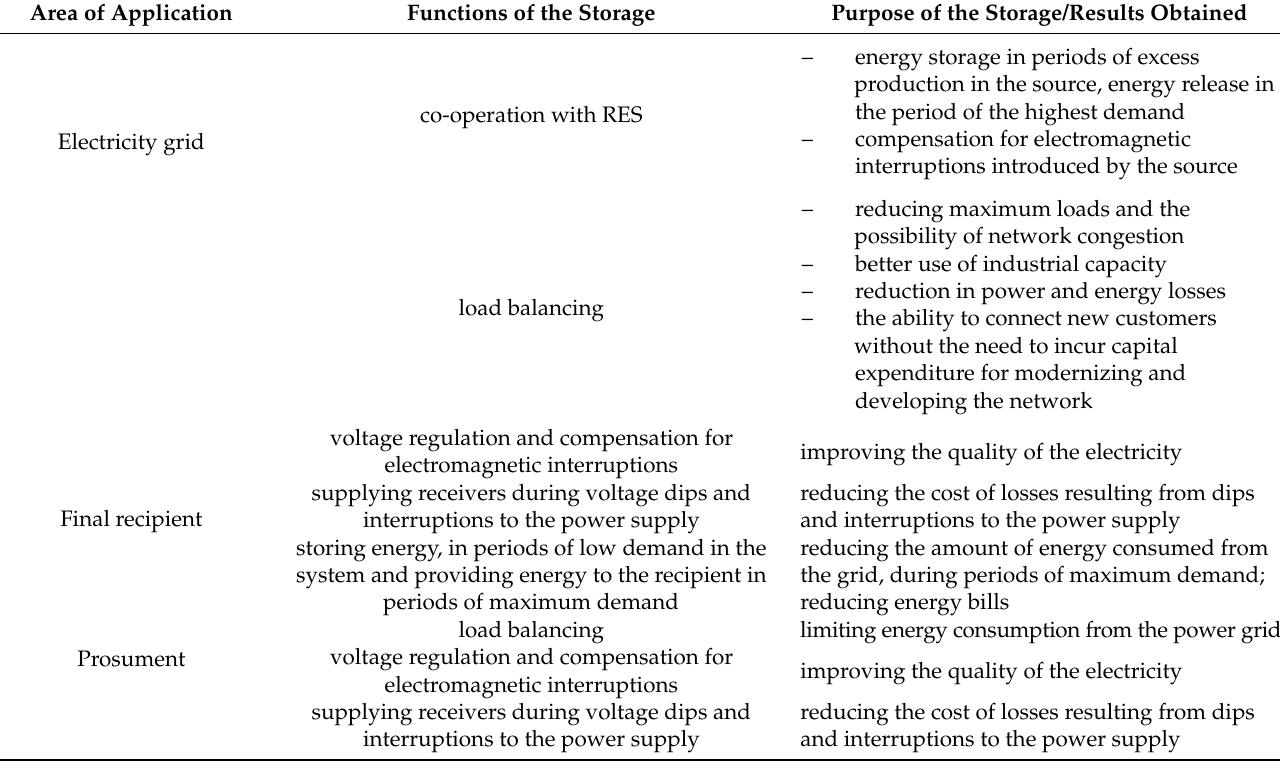
Table 7. Storing electric energy